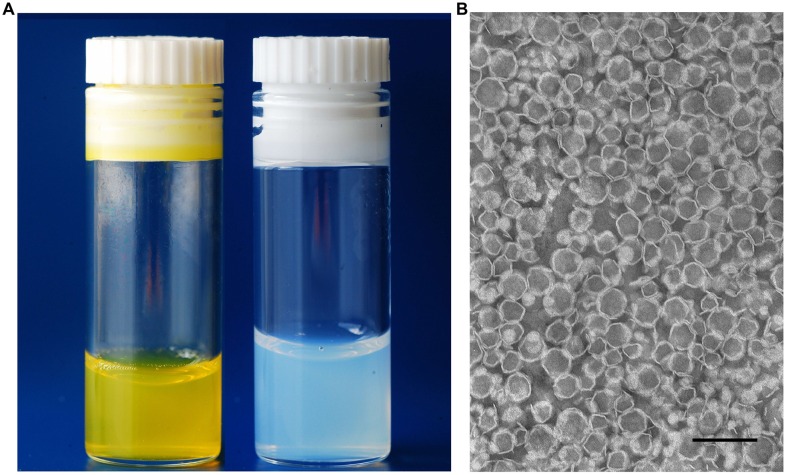
Appearance of liposomal formulations.(A) Cur-loaded liposomes (left) and free liposomes (right). (B) TEM images of Cur-loaded liposomes (H5 formulation). Scale bar represents 200 nm.